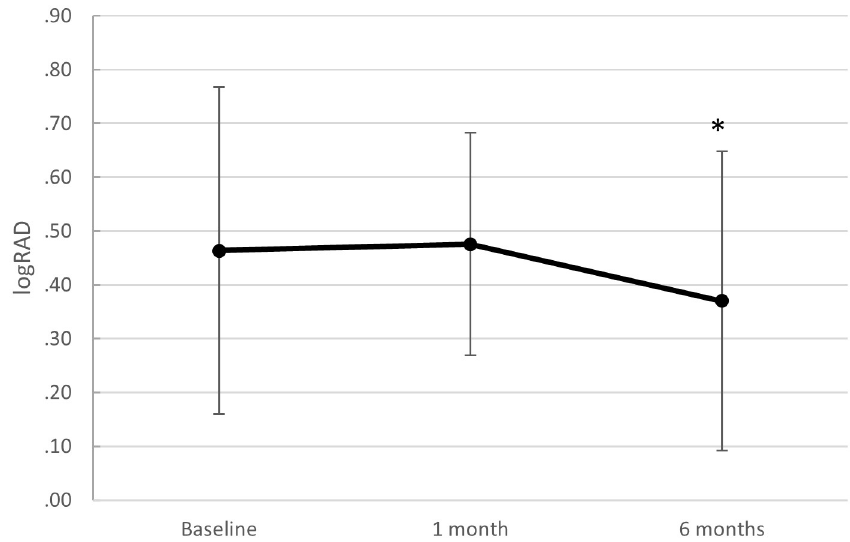
Fig 5. Reading acuity recovery. Reading acuity (RA) from baseline before surgical repair of macula-involving primary rhegmatogenous retinal detachment with vitrectomy and gas. The small and variable sample sizes with possible bias may explain the lack of statistical significance. Whiskers indicate standard deviations and the asterisk ( � ) indicates a significant difference compared to 1 month (p = 0.026); n = 11 at baseline, n = 29 after 1 month, and n = 30 after 6